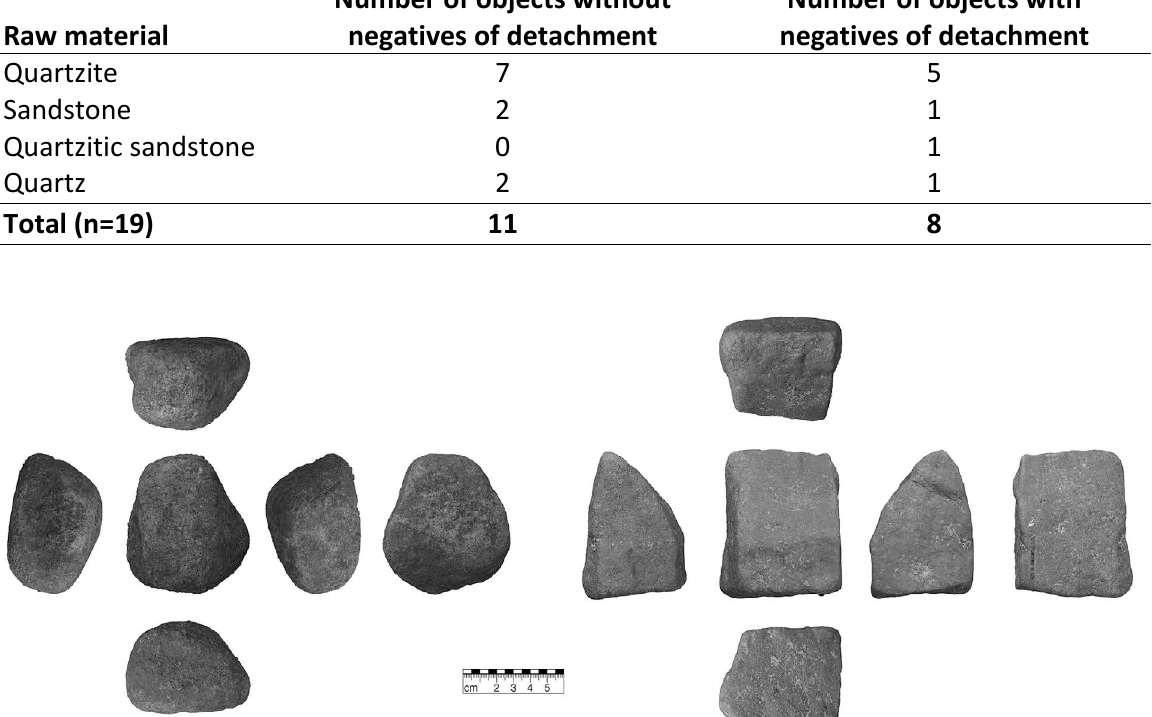
Figure 9. Example of a hammerstone and anvil. a) Hammerstone from quartzite showing bright crushing zones on rounded parts (GER10.226-058.205) and b) Anvil from quartzite showing a blocky morphology, plane surfaces and abrasion on edges